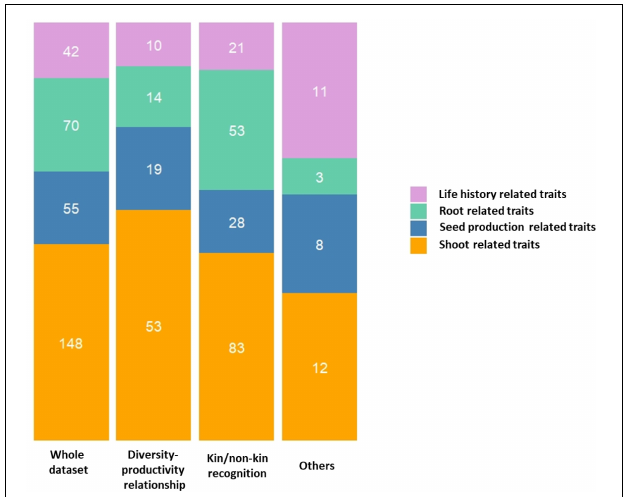
FIGURE 3 | Stacked barplots illustrating the distribution of studies based on trait categories according to different rationales. The number of traits studied within each category are indicated within each